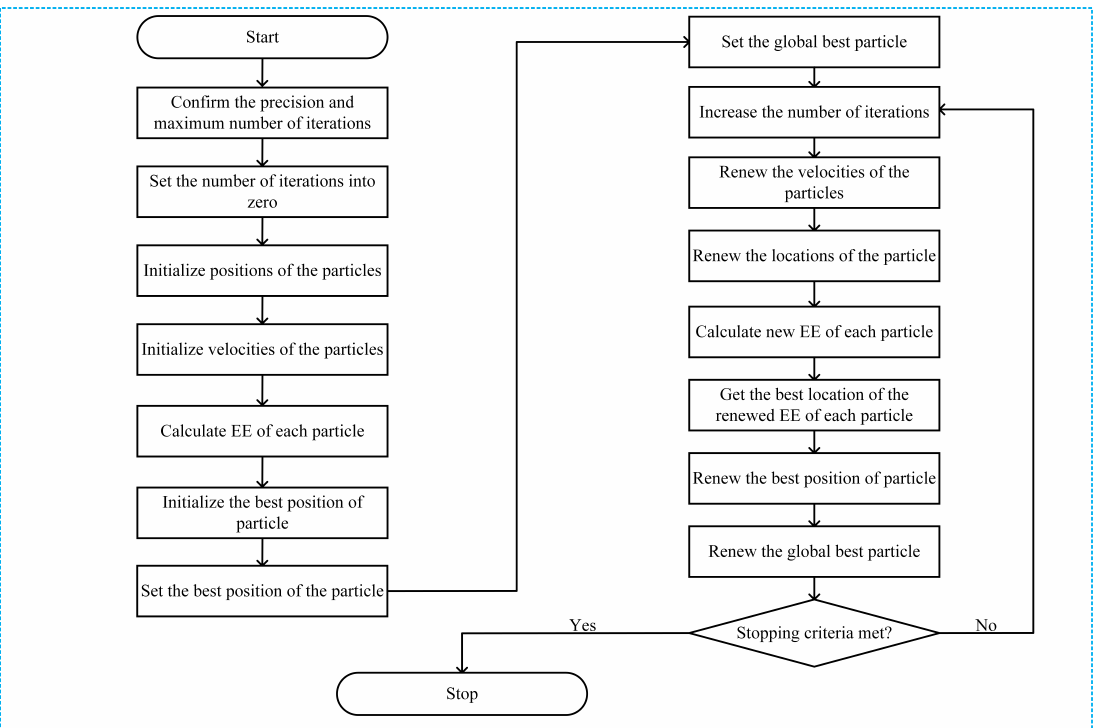
Figure 9. Flowchart of the proposed PSO algorithm for